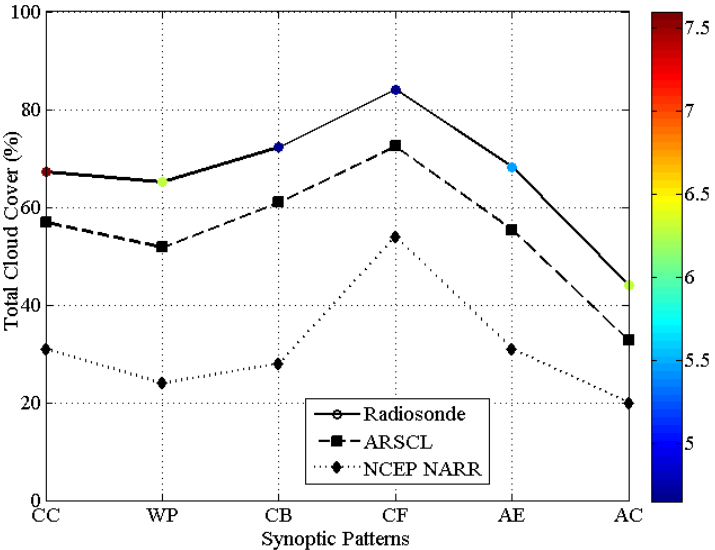
Figure 5. Total cloud cover derived from the radiosonde data (solid line), ARSCL product (long dashed line), and NCEP NARR (short dashed line) for the six synoptic patterns (CC, WP, CB, CF, AE and AC) during 2001–2010 at the SGP site. The color of the dots in radiosonde data represents the relative occurrence frequency (%) of each synoptic pattern during the period analyzed.